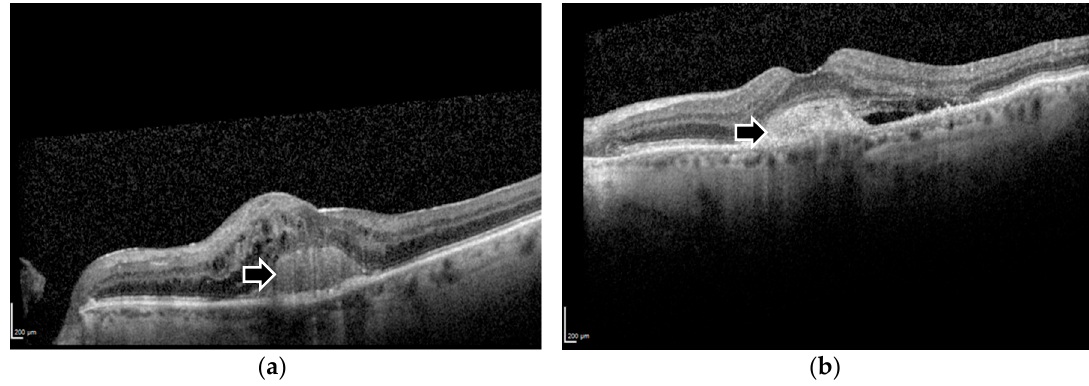
Figure 2. Spectral-Domain Optical Coherence Tomography images demonstrating foveal subretinal hyper-reflective material that is ( a ) distinct and ( b ) indistinct from the underlying retinal pigment epithelium. Black arrows indicate the respective morphological features.